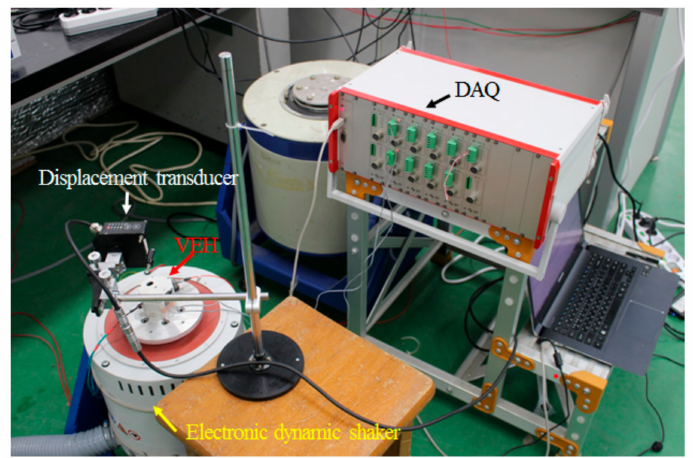
Figure 3. Structural performance test setup.